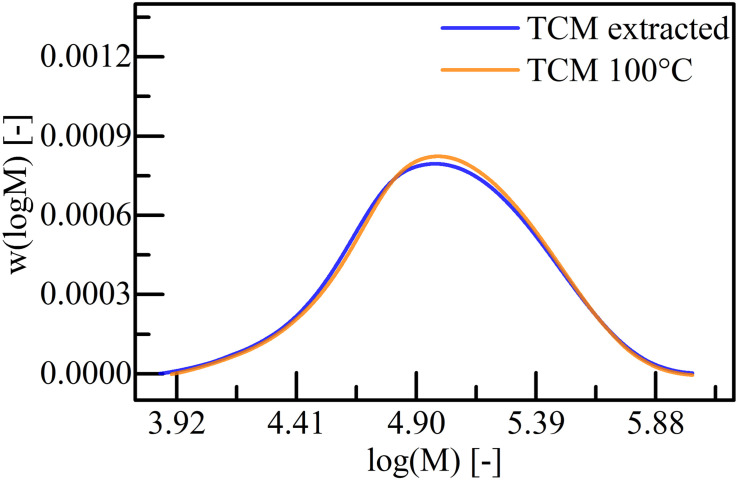
Distribution of the logarithmic molecular weight for P(HB-co-HHx) extracted with chloroform (TCM) at RT and incubated for 4 h at 100°C and precipitated with n-heptane. The extraction was performed in a Soxhlet apparatus under reflux conditions.